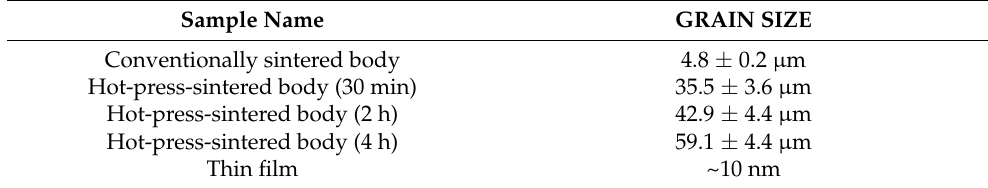
Table 1. Average grain size of (Sr 0.99 Eu 0.01 )Al 2 O 4 samples calculated using the intercept method under different fabrication